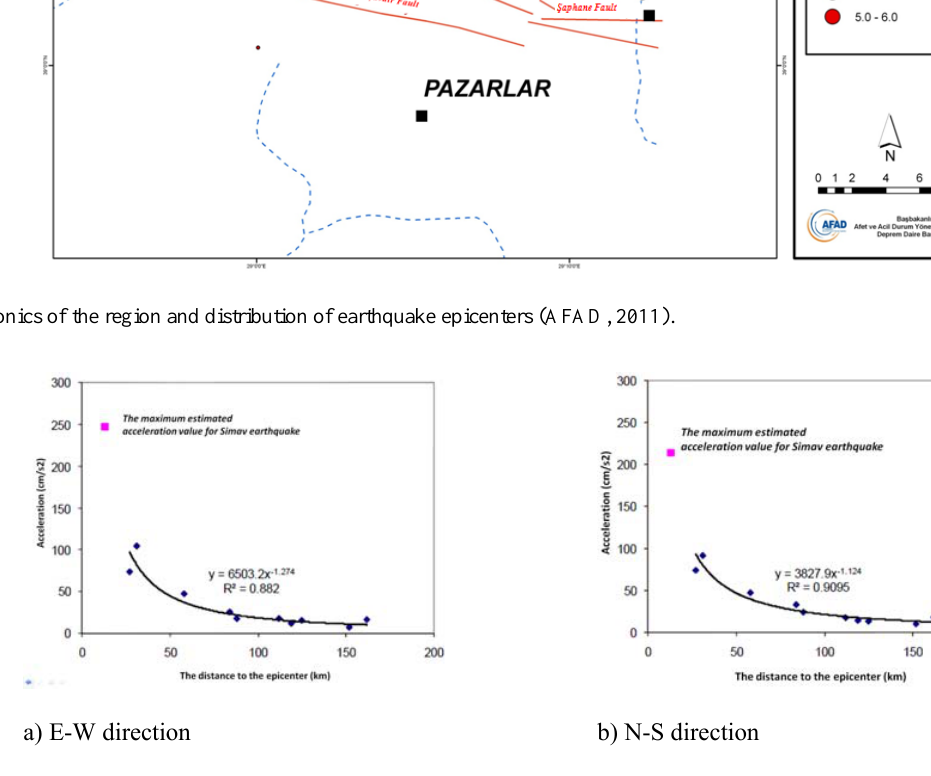
Fig. 2. Relationship between epicentral distance and maximum Fig. 1. Relationship between epicentral distance and maximum acceleration. 3